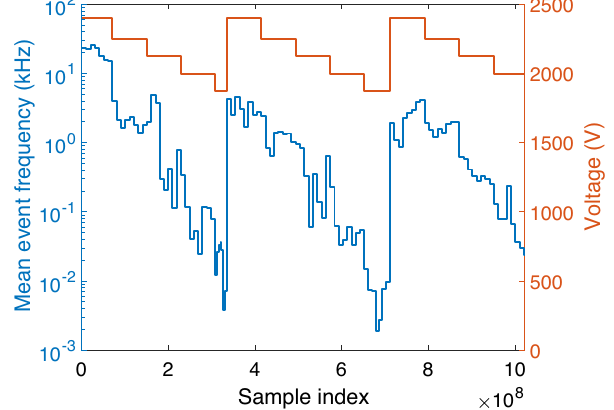
FIG. 8. Applied voltage and spike frequency over the course of measurement series C. The time in the horizontal axis is shown in units of oscilloscope samples, with the time intervals between the windows